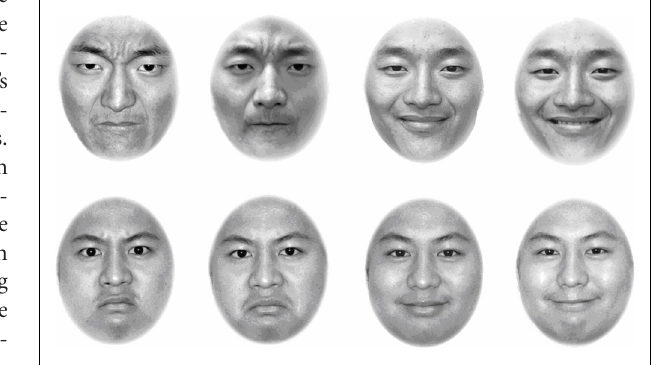
FIGURE 1 | Eight face photos used in Experiment 1. The top row of the four photos comes from Model A, and the bottom row of the four photos comes from Model B. In both the top and bottom rows, the first two photos show angry expressions, with a small difference in emotional intensity between them, and the last two photos show happy expressions, also with a small difference in emotional intensity between them.The discriminability of expression was low, with a RT of 538 ms. and the discriminability of identity was high, with a RT of 475